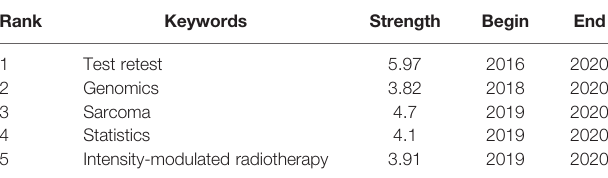
TABLE 2 | Top 5 keywords in the network burst